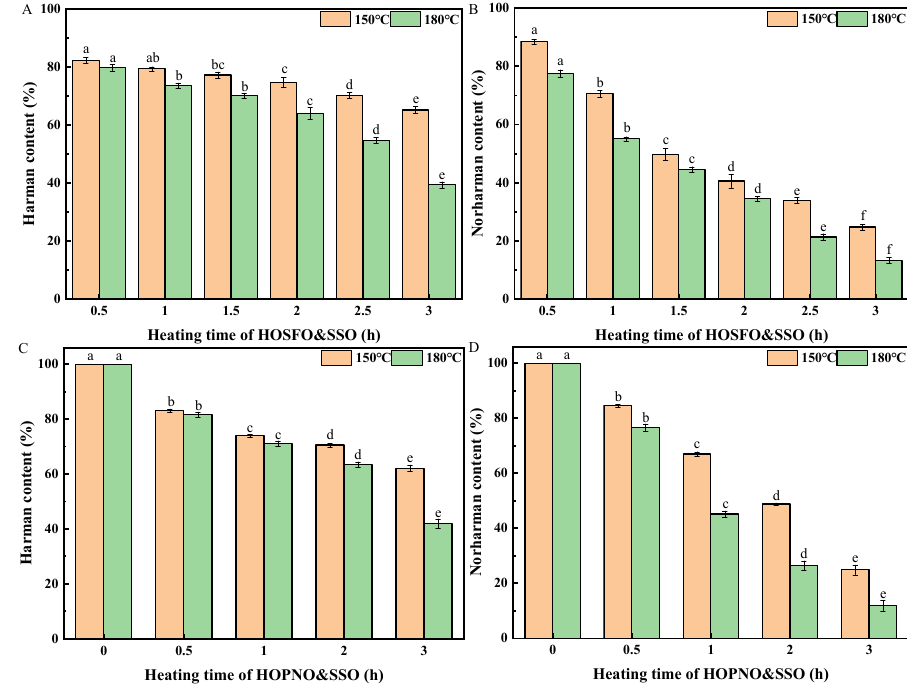
Figure 4. The content of harman in high-oleic-acid sunflower seed oil blend (HOSFO&SSO) ( A ), the content of norharman in high-oleic-acid sunflower seed oil blend (HOSFO&SSO) ( B ), the content of harman in high-oleic-acid peanut oil blend (HOPNO&SSO) ( C ), the content of norharman in high-oleic-acid peanut oil blend (HOPNO&SSO) ( D ). Different superscript letters indicate a significant difference at p -value < 0.05.